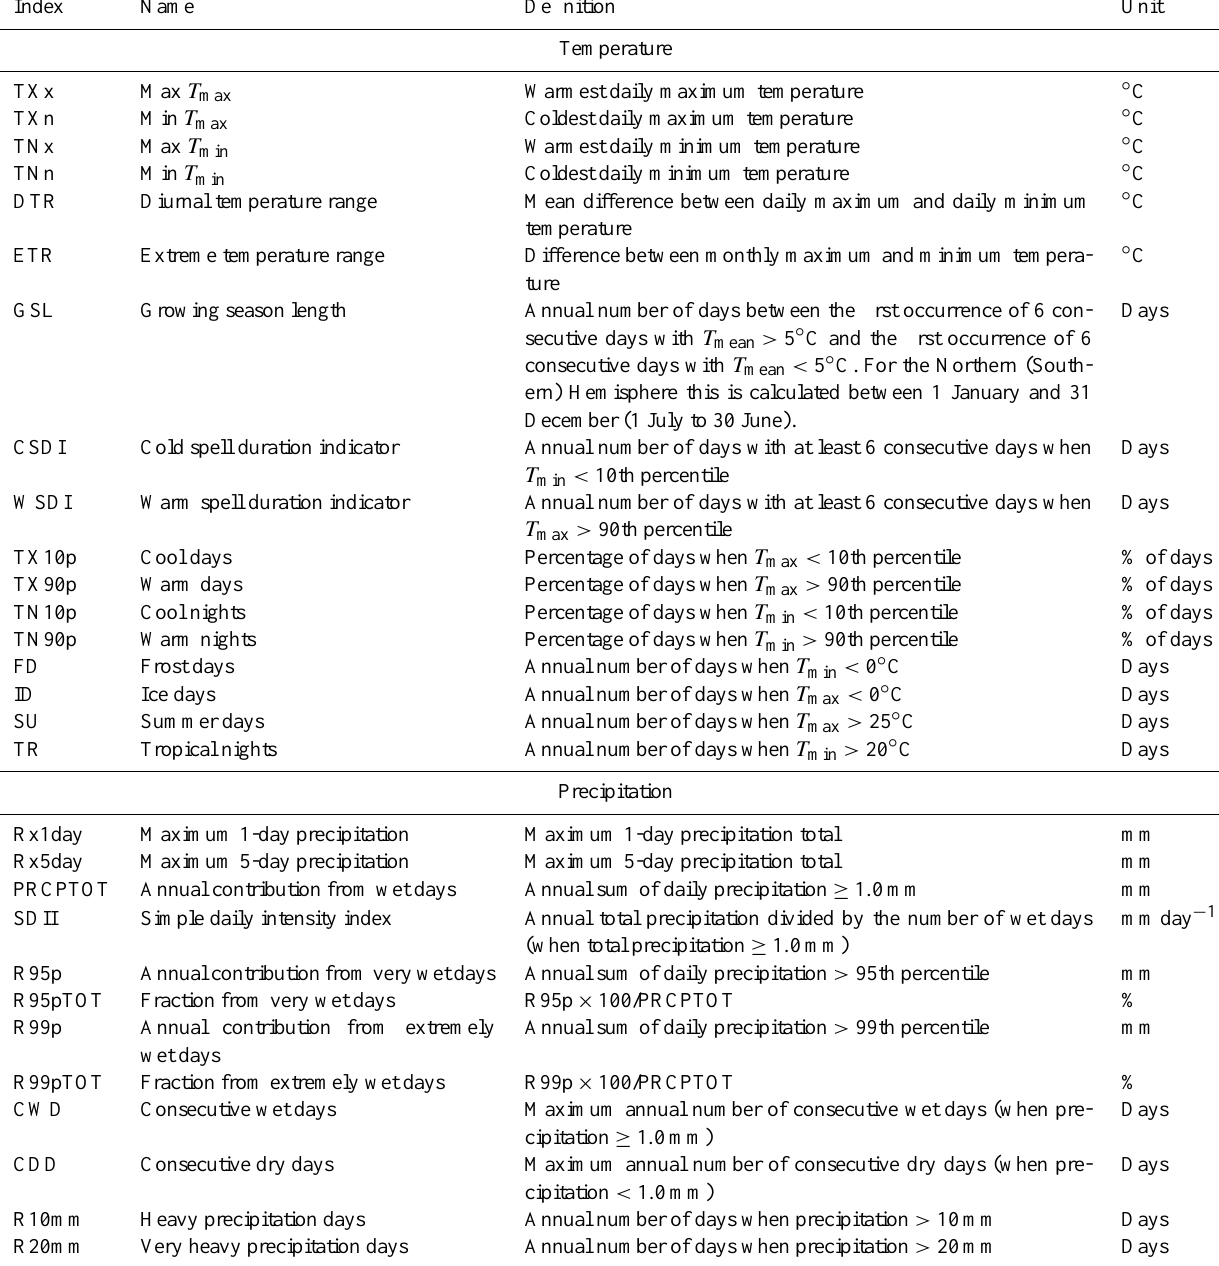
Table 1. The abbreviations, definitions and units of all the indices assessed in this